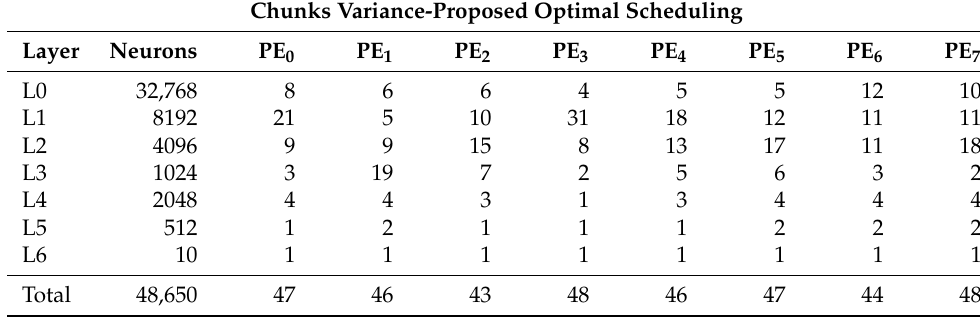
Table 3. Figures of variance when the chunks of neurons are assigned following the proposed ILP and variance-based optimal